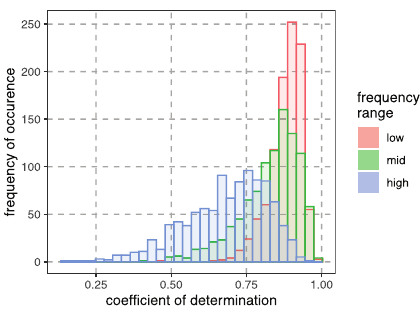
Figure 11. Histogram of the occurences of the best choices of the low frequency two-parameter model feature selection